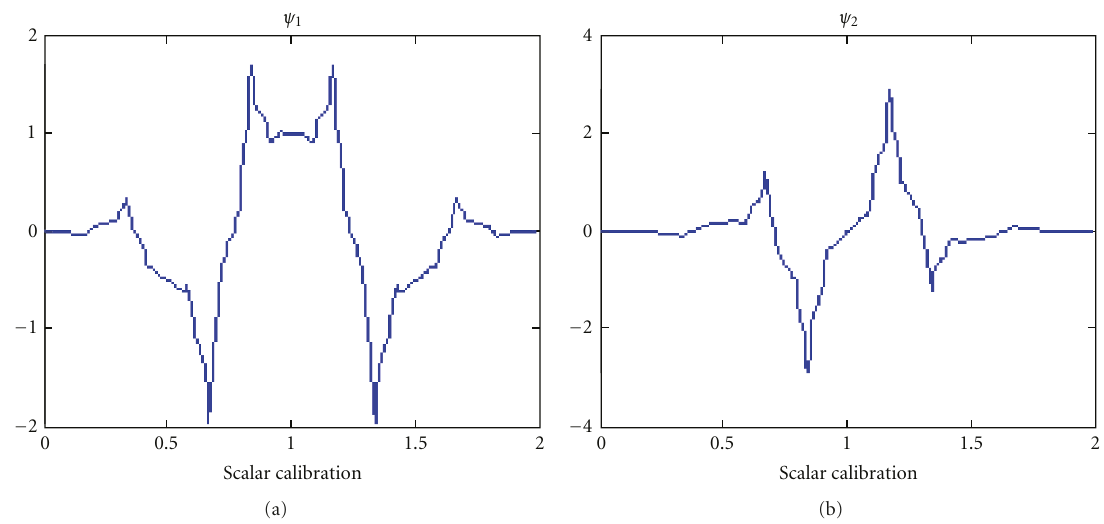
Figure 4: The wavelet functions on interval [0, 2] generated by the lengh-3 high-pass filter with θ = π/ 6.